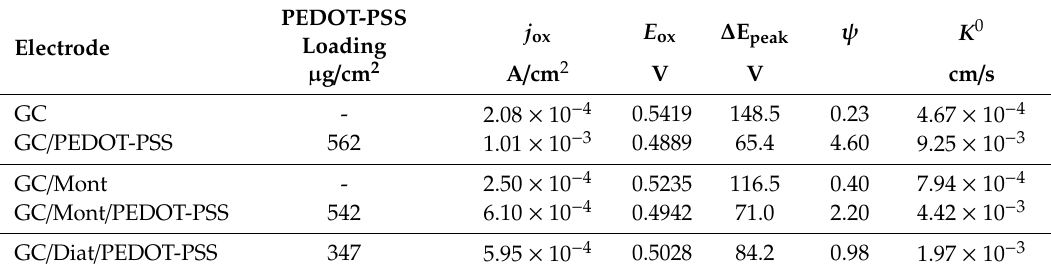
Table 2. Anodic peak current density ( j ox ) and potential ( E ox ), peak potential separation ( ∆ E p ), Nicholson’s charge transfer parameter ( ψ ) [62], and calculated standard rate constant ( K 0 ) for